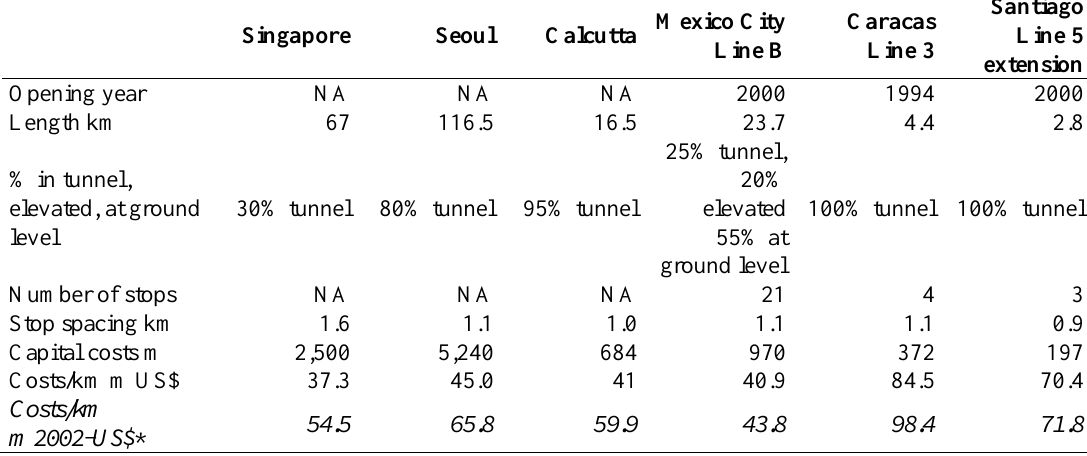
Table 3. Capital costs per route-kilometre for six metros in Asian and Latin American nations